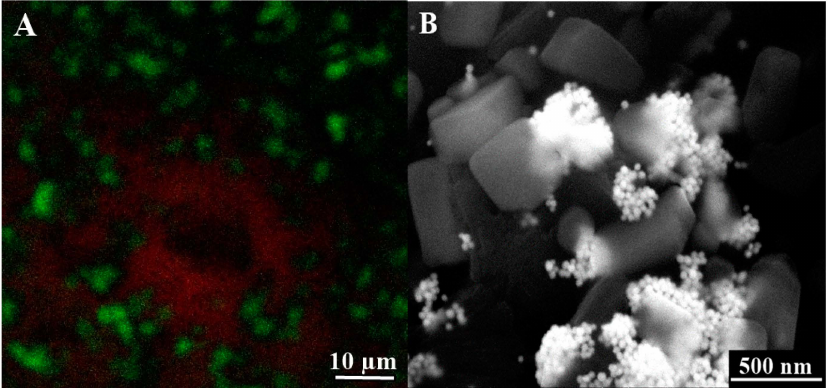
Figure A1. The LSCM and ESEM images of the evaporated DNA/GNPs solution precipitate; ( A ) LSCM image. The 514 nm was used as the pump beam. Green spots correspond to scattered light from CTAB/DNA complexes and GNPs aggregations. The red area corresponds to emitted light from NB bound to DNA molecules, organized in a liquid crystalline phase, detected in the 650–750 nm range; and ( B ) ESEM image. The DNA/CTAB complexes are in the form of cubic